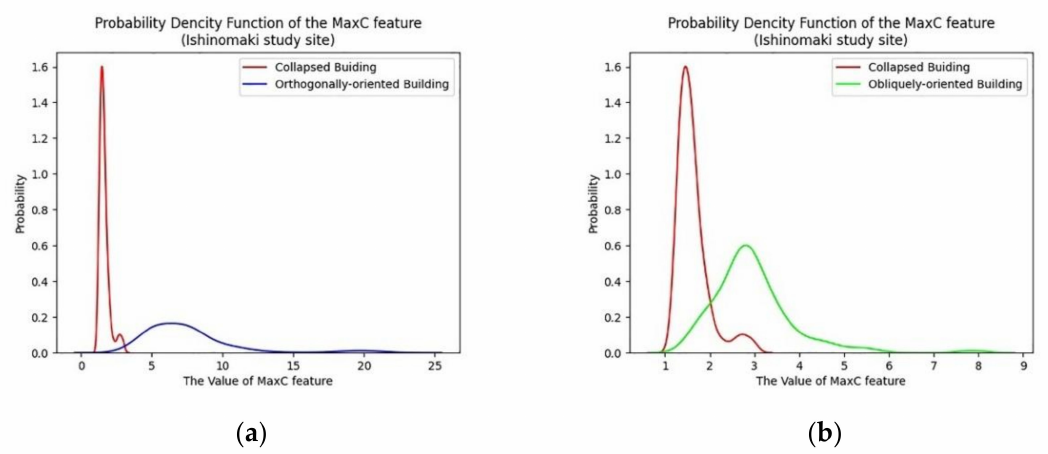
Figure 22. The pdfs of the MaxC feature in the Ishinomaki study site: ( a ) pdfs of collapsed buildings and orthogonally- oriented buildings; ( b ) pdfs of collapsed buildings and obliquely-oriented buildings.